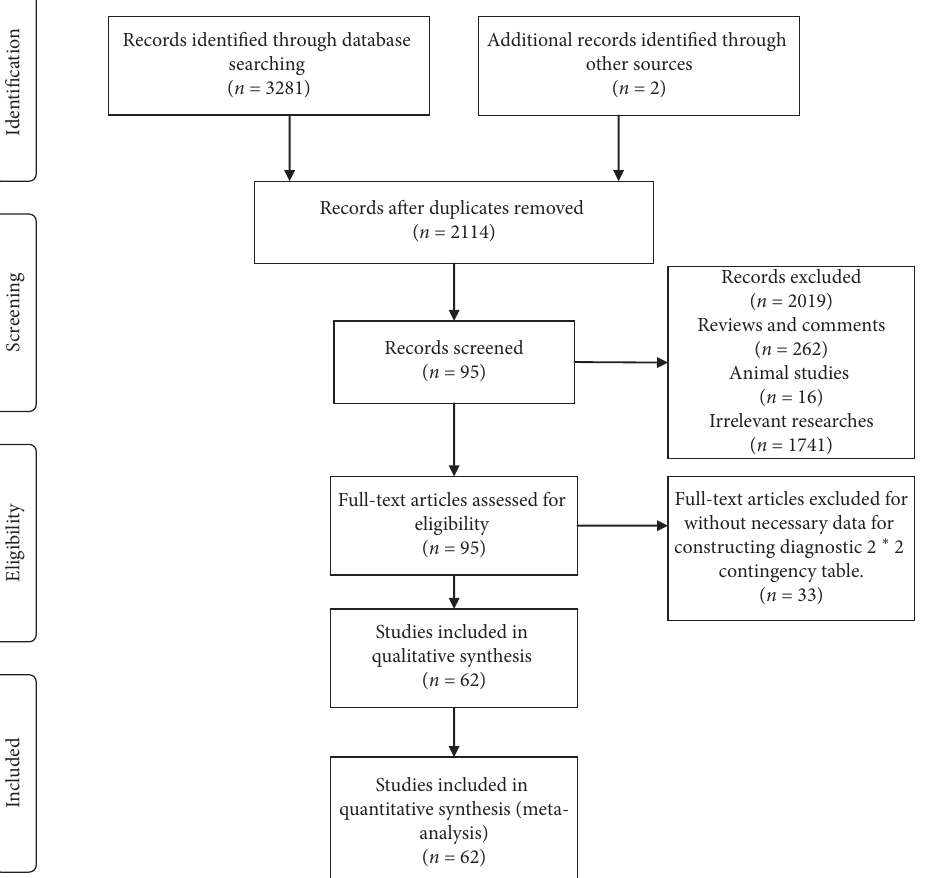
Figure 1: Flowchart showing the selection of articles included in the